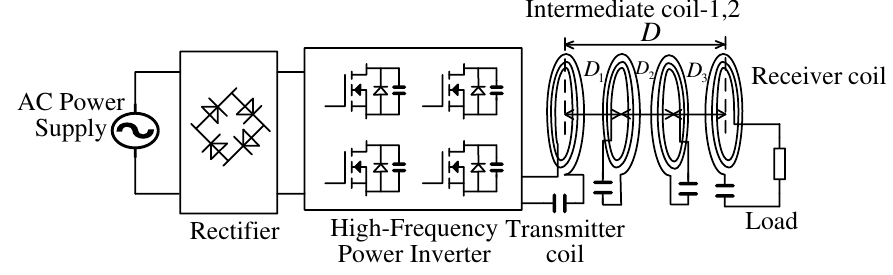
Figure 3. The structure of the MCR-WPT system with a two-intermediate